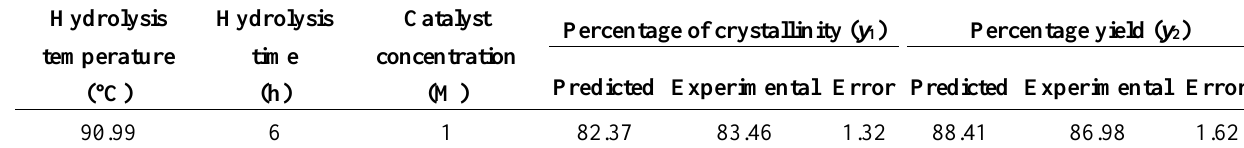
Table 4. Process parameter optimization for the acid hydrolysis of MCC in the presence of FeCl 3